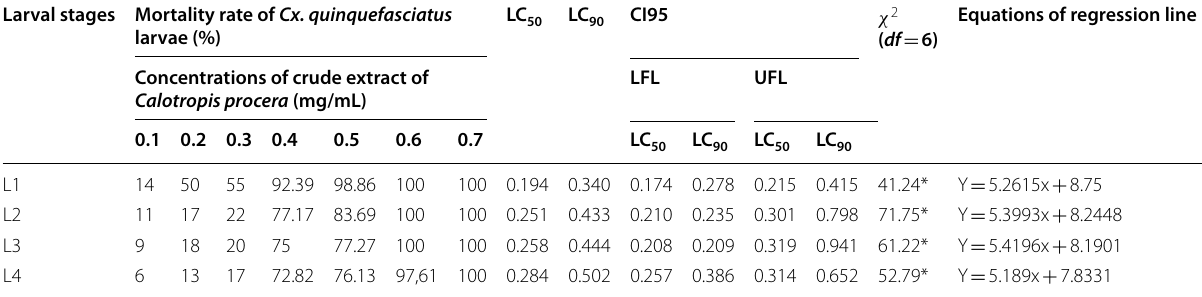
LFL, lower fiducidal limit; UFL, upper fiducidal limit; χ 2 , Chi- square value; df , degrees of freedom; CI, confidence interval * Significant at P < 0.05 level